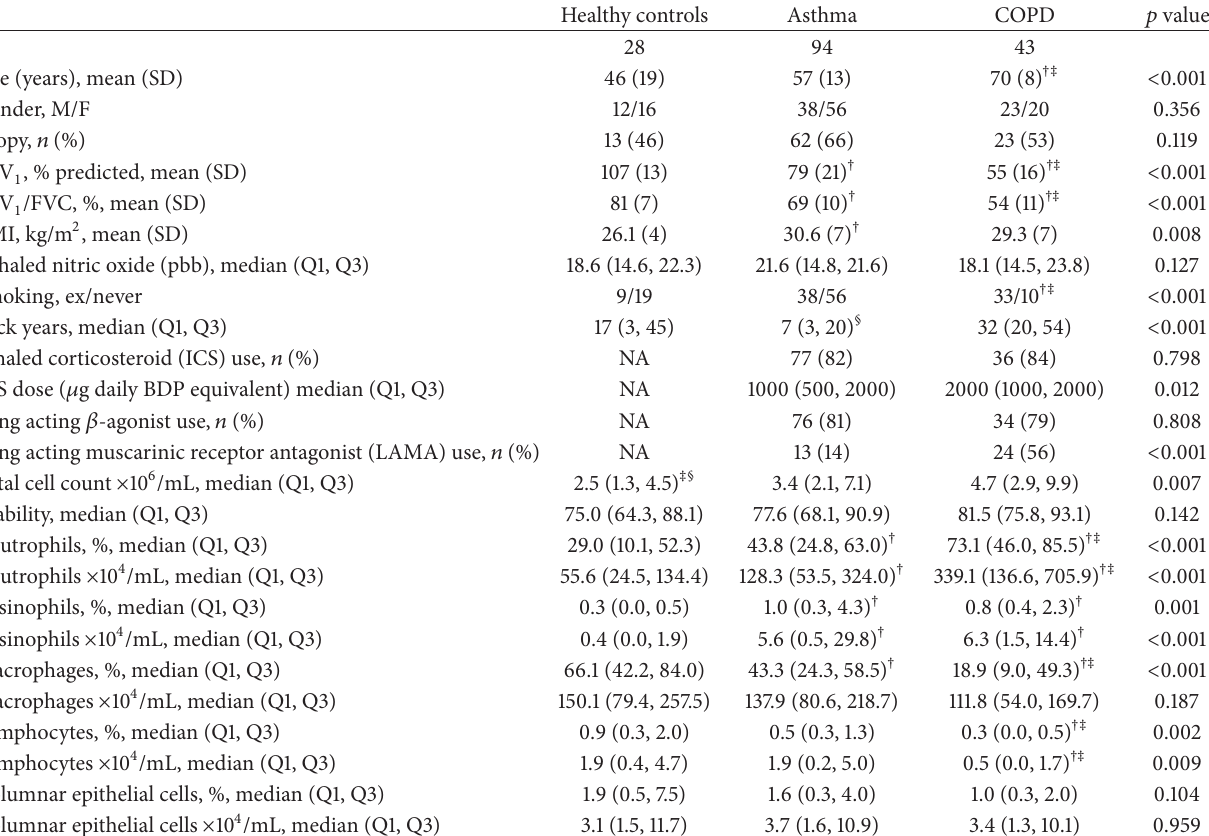
Table 1: Clinical characteristics and sputum cell counts in patients with inflammatory airway diseases compared to healthy controls. Healthy controls Asthma